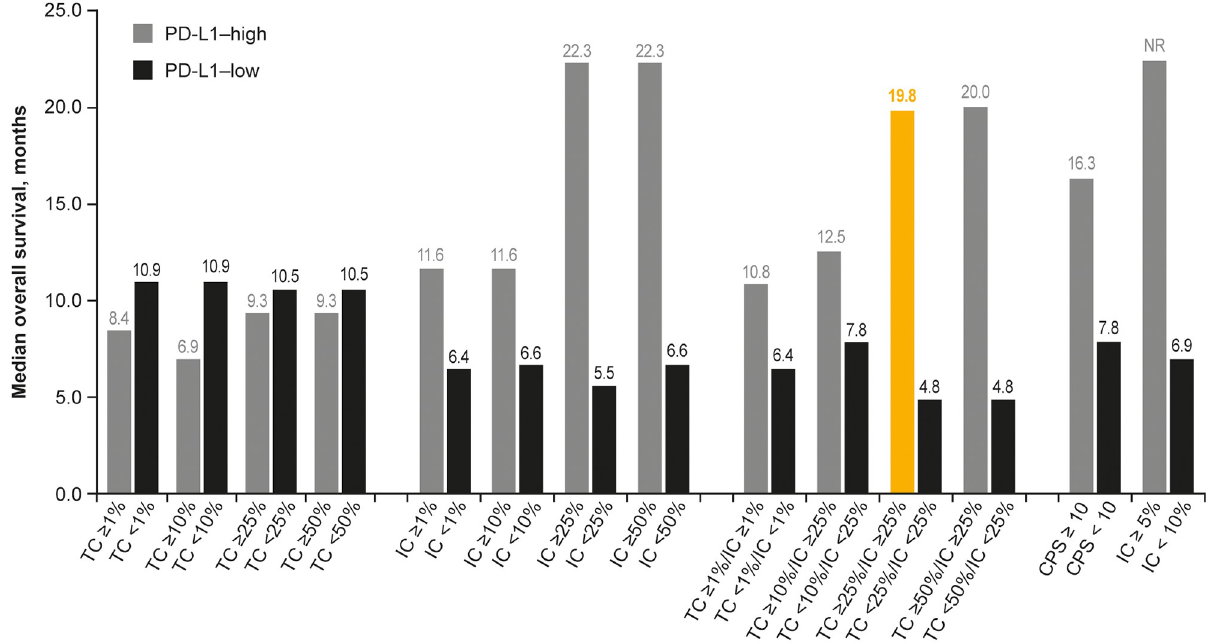
Fig 5. Median overall survival in Study 1108 at different TC and IC cutoffs for defining positive (PD-L1–high) and negative (PD-L1–low) expression. IC, tumor-infiltrating immune cells; PD-L1, programmed death ligand-1; TC, tumor cells. Highlighted bar indicates the PD-L1 cutoff previously used to investigate response to durvalumab.